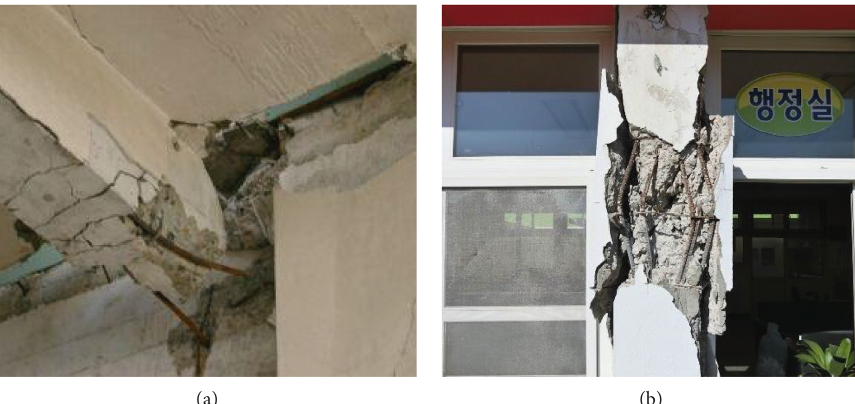
Figure 3: Corrosion of RC beams and columns damaged during earthquakes. (a) The 2004 Niigata-ken Chuetsu Earthquake in Japan (b) The 2017 Pohang Earthquake in